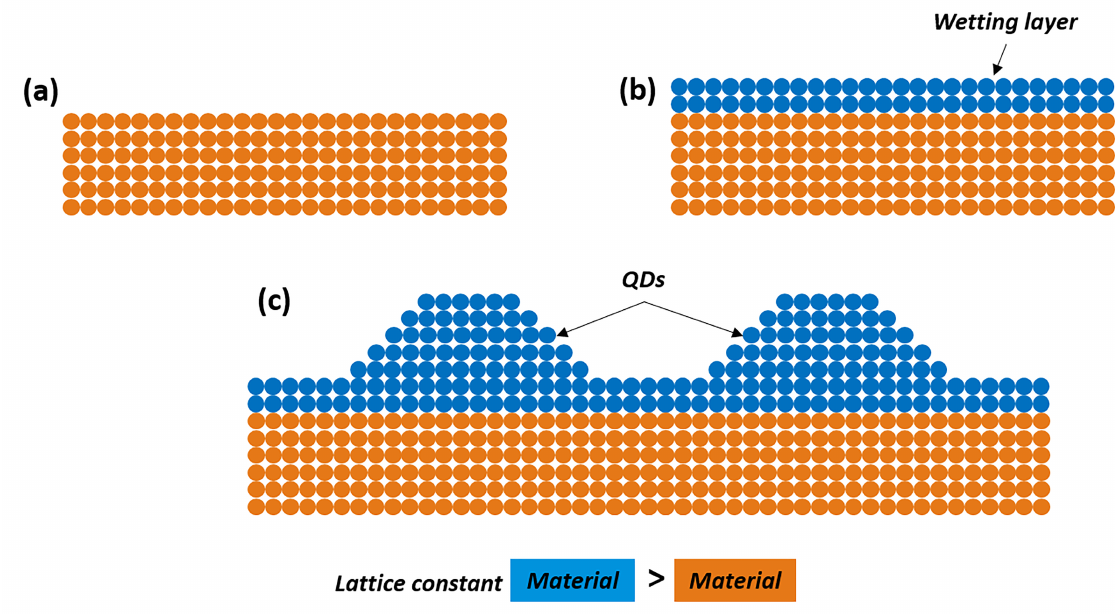
Figure 1. Schematic process showing the formation of SKQDs: ( a ) buffer layer; ( b ) formation of wetting layer; ( c ) QD formation. QD formation is decided by the lattice-mismatch between the two materials.